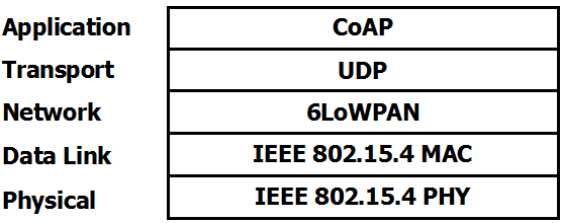
Figure 10. 6LowPAN protocol stack.